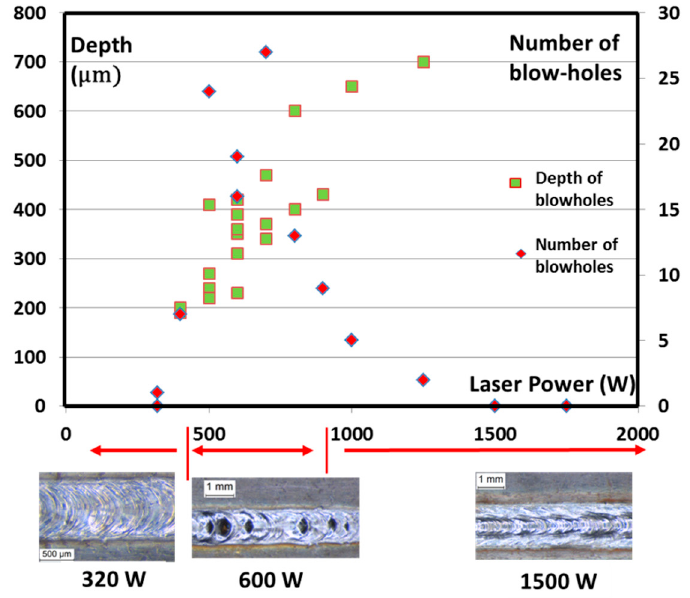
Figure 10. Number of blow-holes on a 45 mm bead length and depth of the blow-holes, as a function of the incident laser power (on mild steel material, 0.6 mm spot diameter; V w = 1 m / min). Typical aspects of surface weld seams for these welding regimes: the conduction, unstable and KH regime.